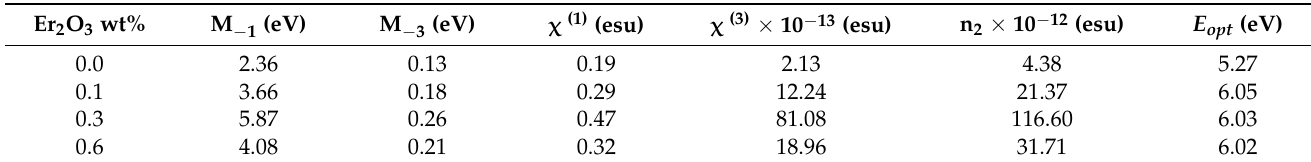
Table 3. Values of optical moments, optical susceptibility, nonlinear refractive index and real optical energy gap for PVC/PVP/Er 2 O 3 blend